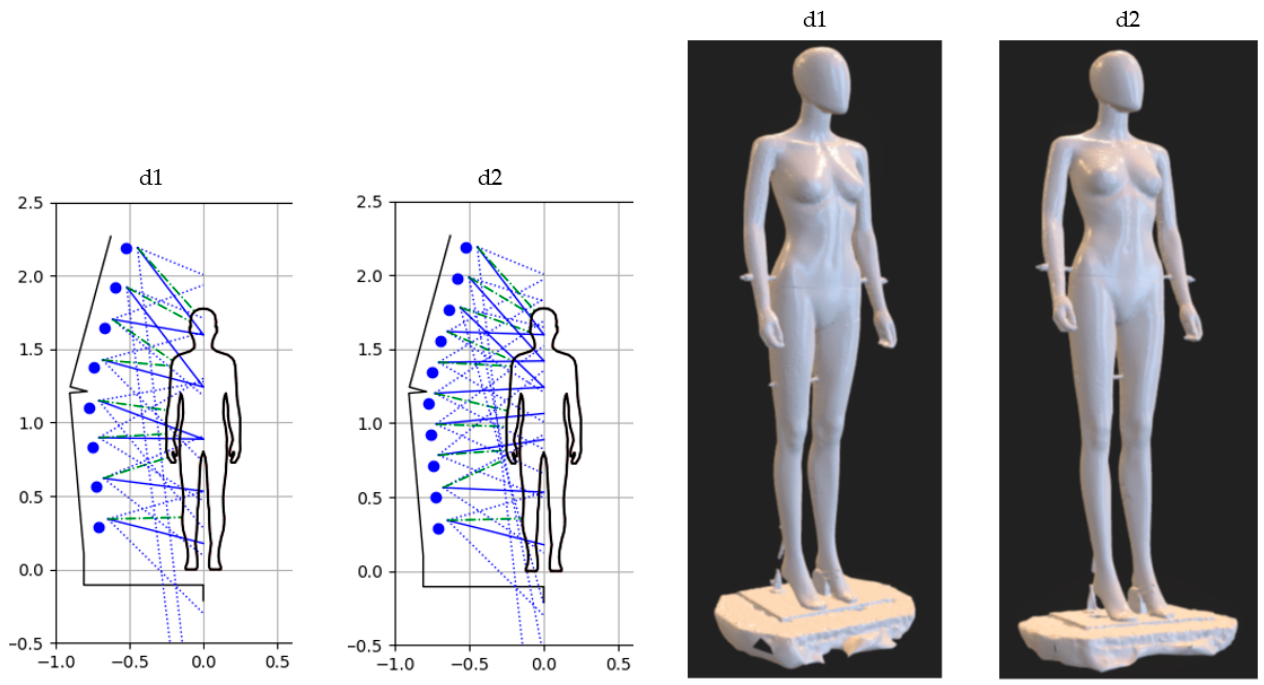
Figure 15. The illustration of camera configuration and visibility as well as the results of the experimental tests of the HUBO scanner for variants d1 and d2.